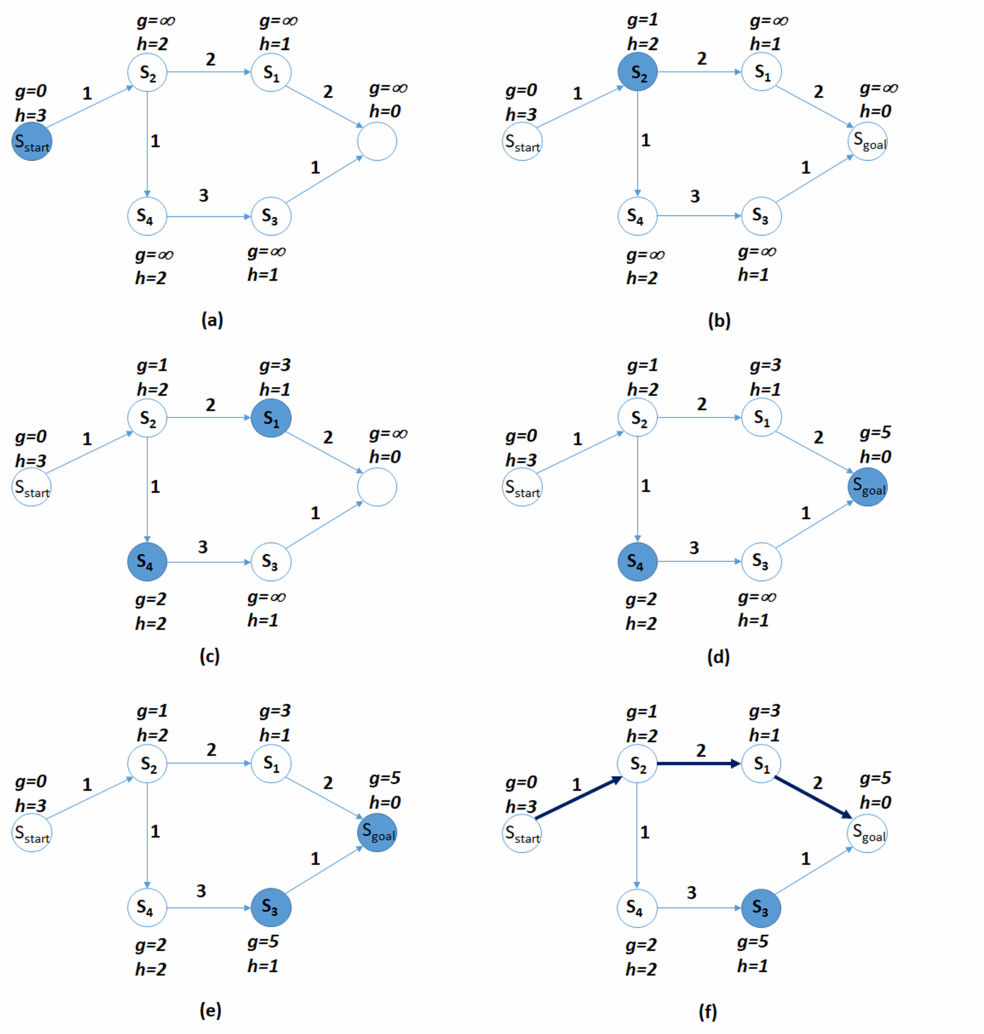
Figure 6. A* algorithm ( a ) after initialization ( b ) after the expansion of S start ( c ) after the expansion of S 2 ( d ) after the expansion of S 1 ( e ) after the expansion of S 4 ( f ) after the expansion of S goal